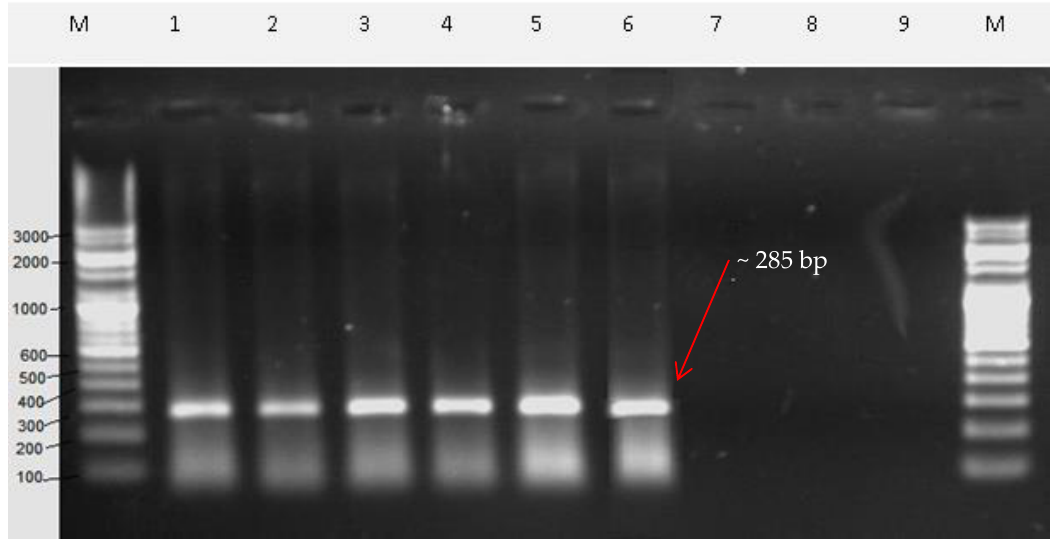
Figure 6. Identification of market samples of Viola serpens with SCAR primers (Vio F & Vio R). Lane M = 100 bp standard DNA marker, Lanes 1–9 = Market samples of Viola serpens.